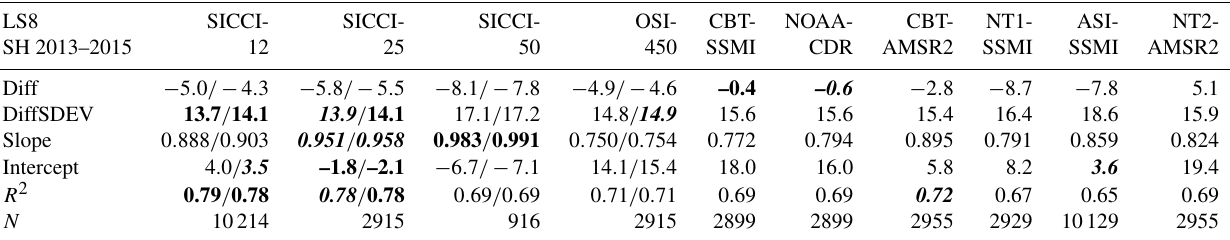
Table 13. Summary of statistical results obtained for 45 melt-condition cases in the Southern Hemisphere. See caption of Table 5 for an explanation of the parameters given. Numbers added to the right of the “/” for SICCI-2 products and OSI-450 denote results obtained using non-truncated